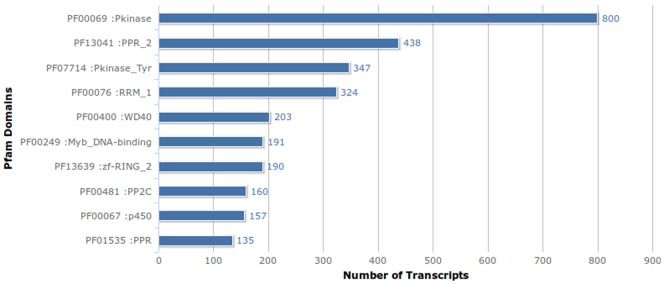
Top ten most expressed Pfam domains.